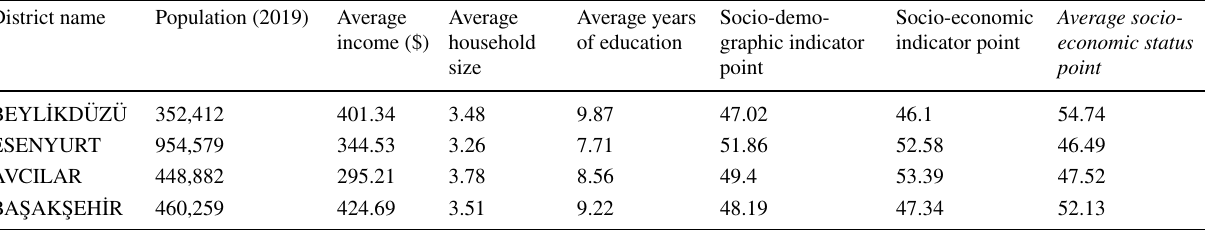
Table 2 Study area population, socio-economic and socio-demographic characteristics